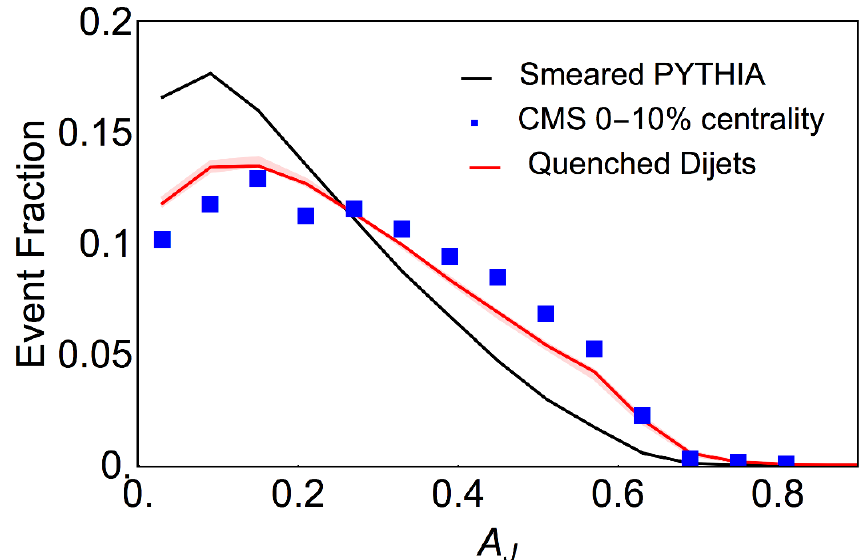
Figure 11 . The dijet asymmetry distribution in our ensemble of holographic jets, before quenching (black curve) and after propagation through the strongly-coupled plasma of section 3 (red curve). The red curve is drawn for a = 2, with the pink band indicating a = 1 : 8 (cid:0) 2 : 5. The CMS measurement of the dijet asymmetry distribution in the 0 { 10 % most central Pb{Pb collisions with p s NN = 2 : 76 TeV from ref. [27] is shown in blue symbols. In order to make a comparison to